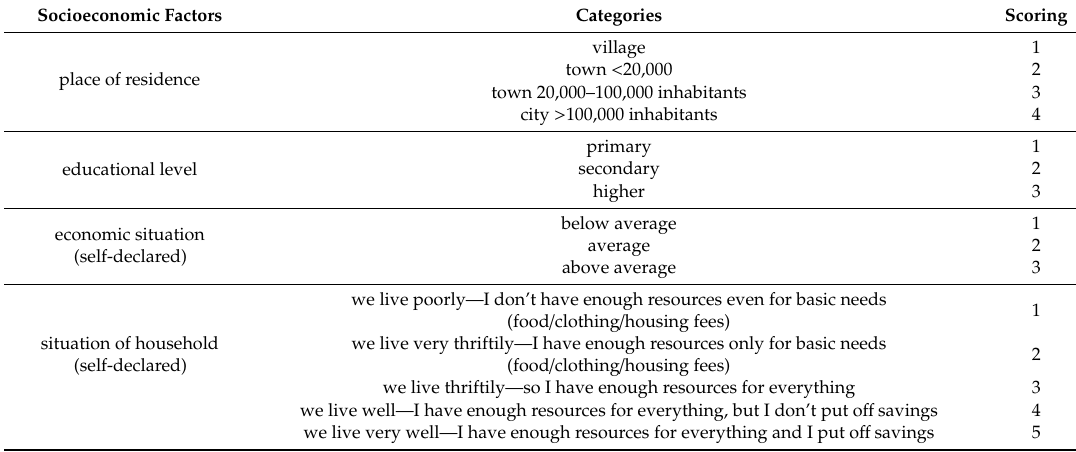
Table 4. Description of the socioeconomic status factors